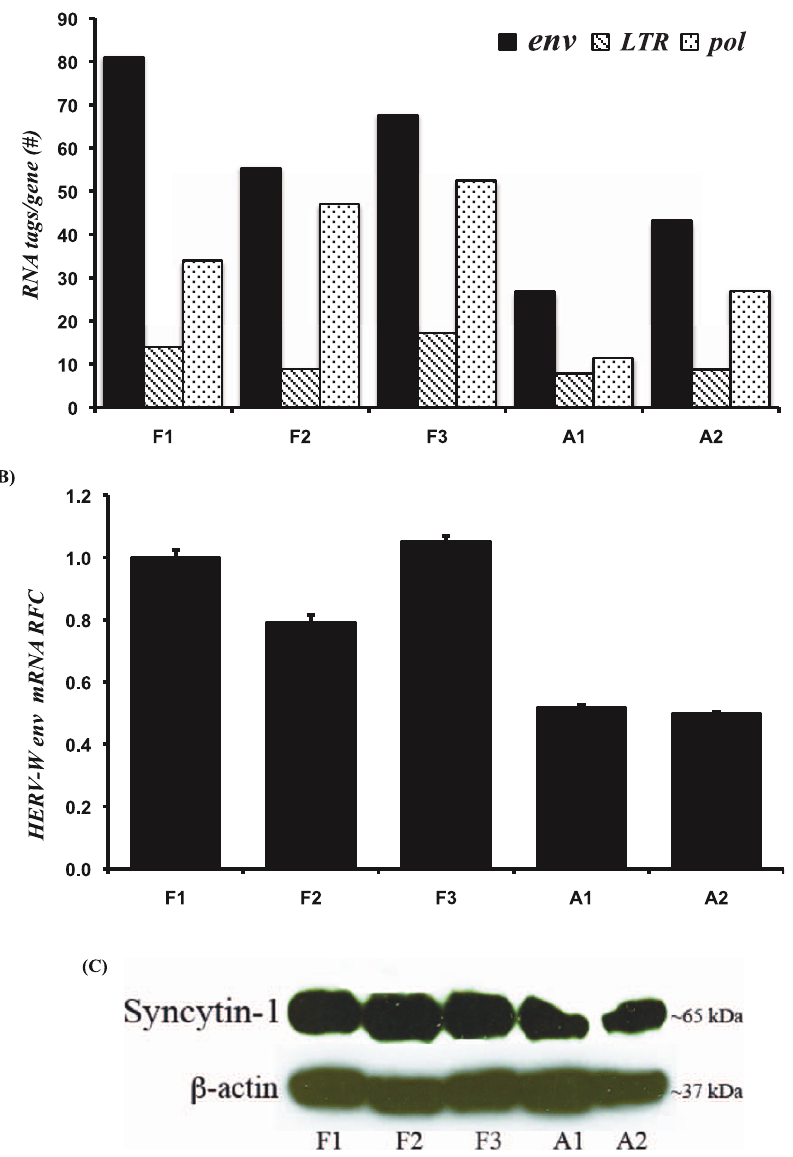
Figure 4. HERV-W env RNA and Syncytin-1 abundance in healthy human fetal and adult brain samples. ( A ) Deep sequencing revealed HERV-W and related - env , - LTR and - pol RNA tags in fetal and adult samples, although the frequency of env tags was highest in all specimens. ( B ) Transcript levels of HERV-W env gene normalized to GAPDH, were highest in fetal brain samples. ( C ) Western blot analysis disclosed up-regulation of Syncytin-1 immunoreactivity in fetal samples relative to b -actin expression.